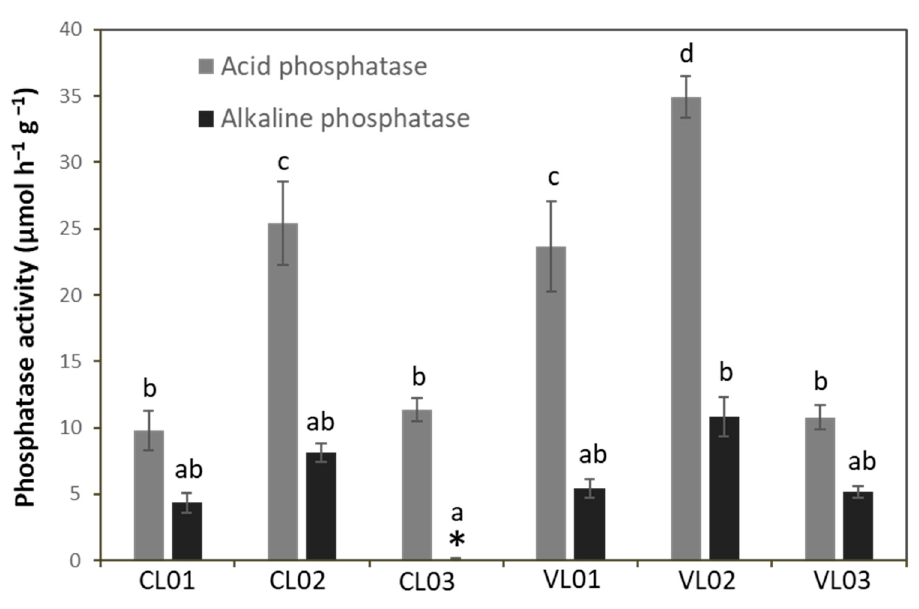
Figure 3. Acid and alkaline phosphatase activity of soil samples. Each value represents the average ± standard deviation (n = 3). Different letters indicate significant differences ( p < 0.05). Different letters above columns represent significantly different ( p < 0.05) values. * represents that alkaline phosphatase activity of sample CL03 was under the detection limit.